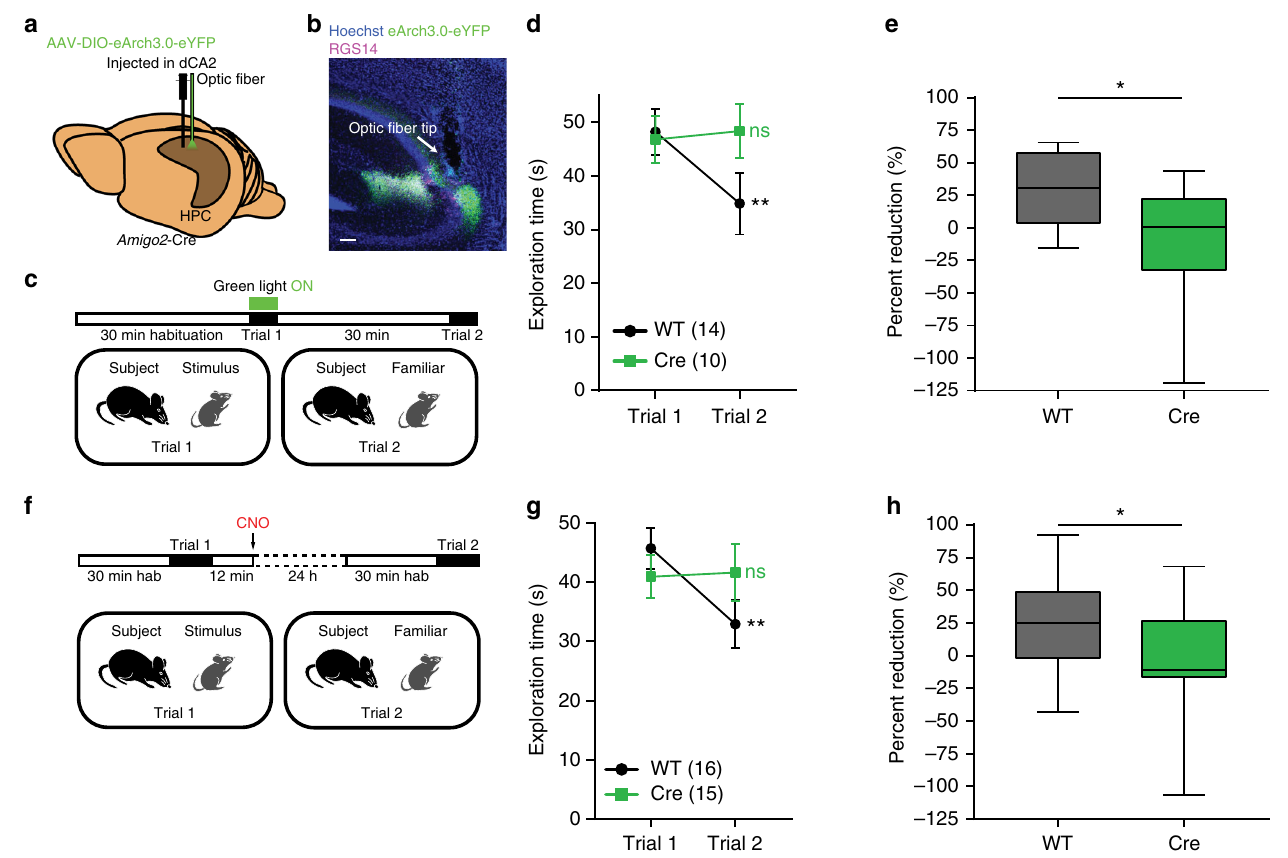
Fig. 3 dCA2 is necessary for social memory encoding and consolidation. a Diagram illustrating injection of AAV-DIO-eArch3.0-eYFP into dCA2 of Amigo2 - Cre and WT littermates. An optic fi ber was implanted above dCA2. b Dorsal HPC coronal section from an Amigo2 -Cre mouse expressing eArch3.0-eYFP in dCA2 (green). Arrow indicates optic fi ber tip location, above dCA2. c Behavior protocol for testing whether dCA2 is required for social memory encoding. Green light was delivered through the optic fi ber during the 2 min of trial 1 of a direct interaction test. Trial 2 was performed 30 min later with light off. d WT mice displayed decreased social exploration during trial 2 (WT: n = 14, P = 0.0074, Sidak ’ s multiple comparisons test) whereas Amigo2 -Cre mice did not (Cre: n = 10, P = 0.9371, Sidak ’ s multiple comparisons test). The groups differed signi fi cantly (two-way ANOVA: treatment × trial F (1,22) = 5.482, P = 0.0287). e Percent reduction in social exploration time was lower in Amigo2 -Cre mice than WT littermates (unpaired t test: t (22) = 2.590, P =